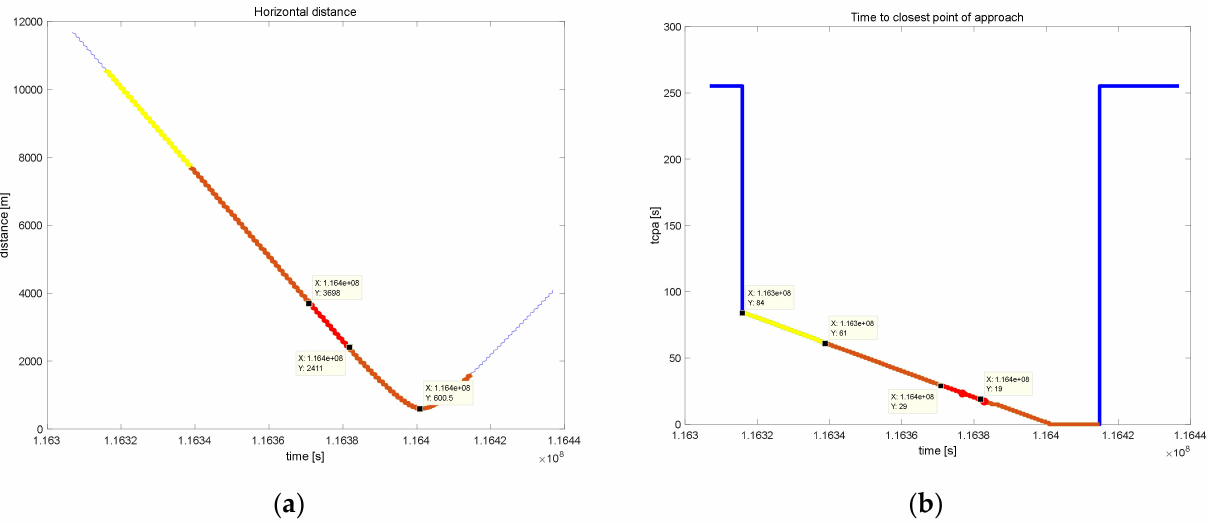
Figure 19. Relative distance ( a ) and time to the closest point of approach ( b ) during the